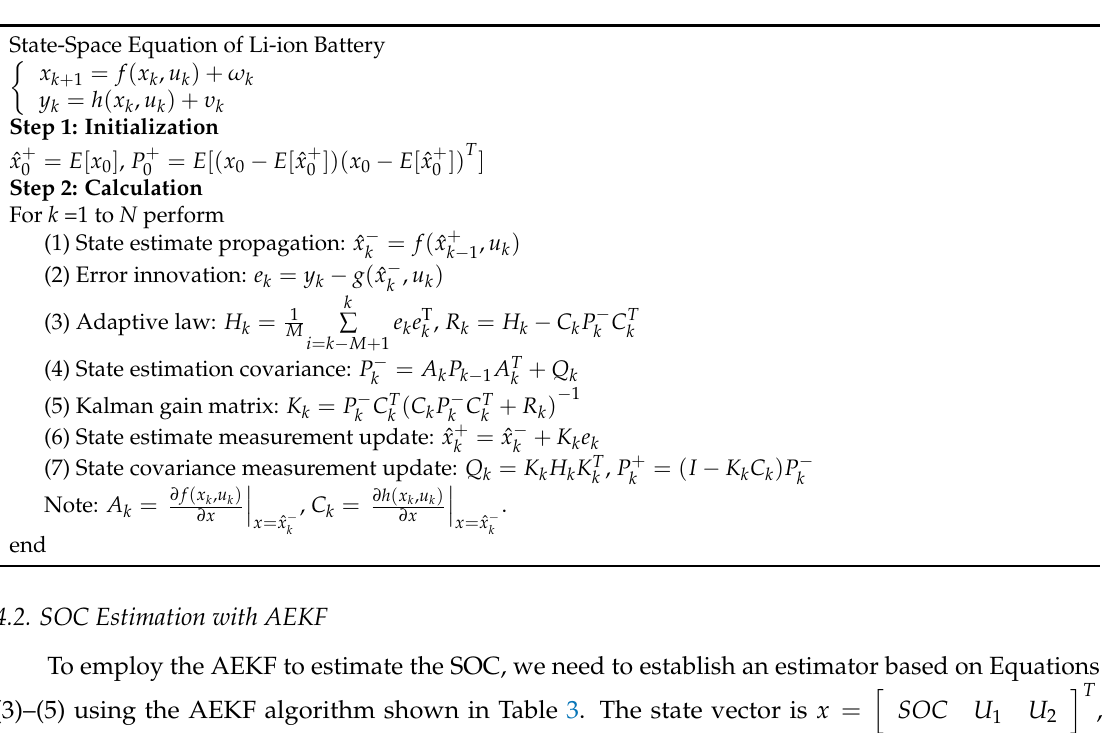
Table 3. Summary of the AEKF